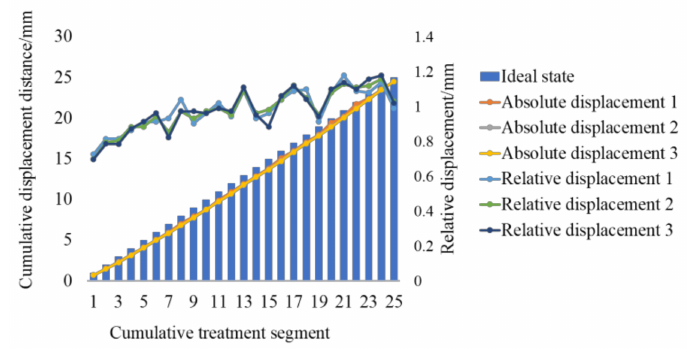
Figure 10. The picture of the in vitro experiment results.